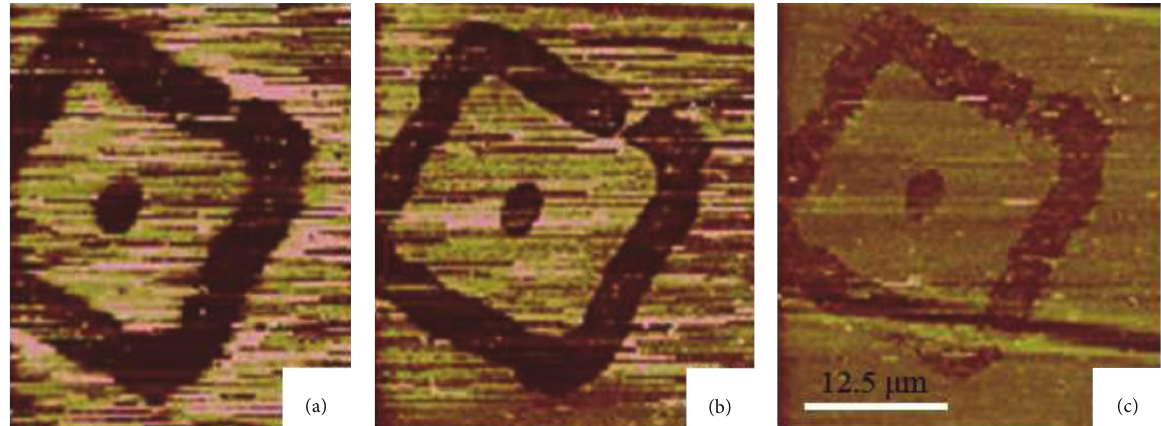
Figure 3: The lateral force images of ODT SAMs in (a) air (20% RH), (b) water for 5 minutes, and (c) water for 70 minutes. The dark part is the ODT SAM pattern, and the bright part is the gold substrate. The scale bar in (c) is the same for all images.